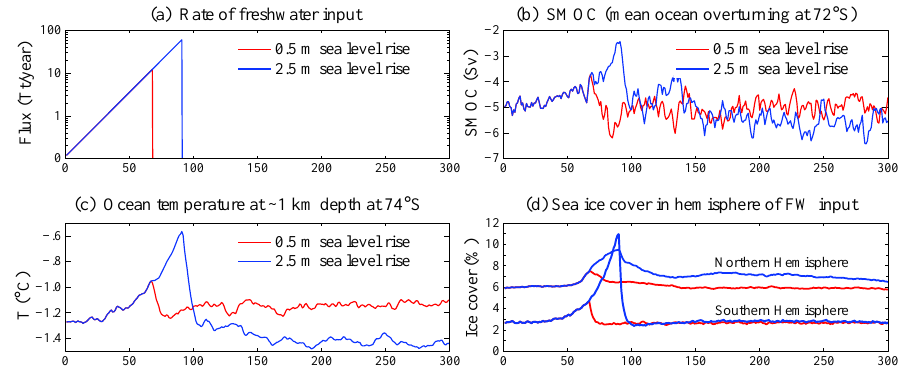
Figure 13. (a) Freshwater input (Ttyear − 1 ) to Southern Ocean (1Tt = 1000km 3 ) . (b, c, d) Simulated overturning strength (Sv) of AABW cell at 72 ◦ S, temperature ( ◦ C) at depth 1.13km at 74 ◦ S, and sea ice cover